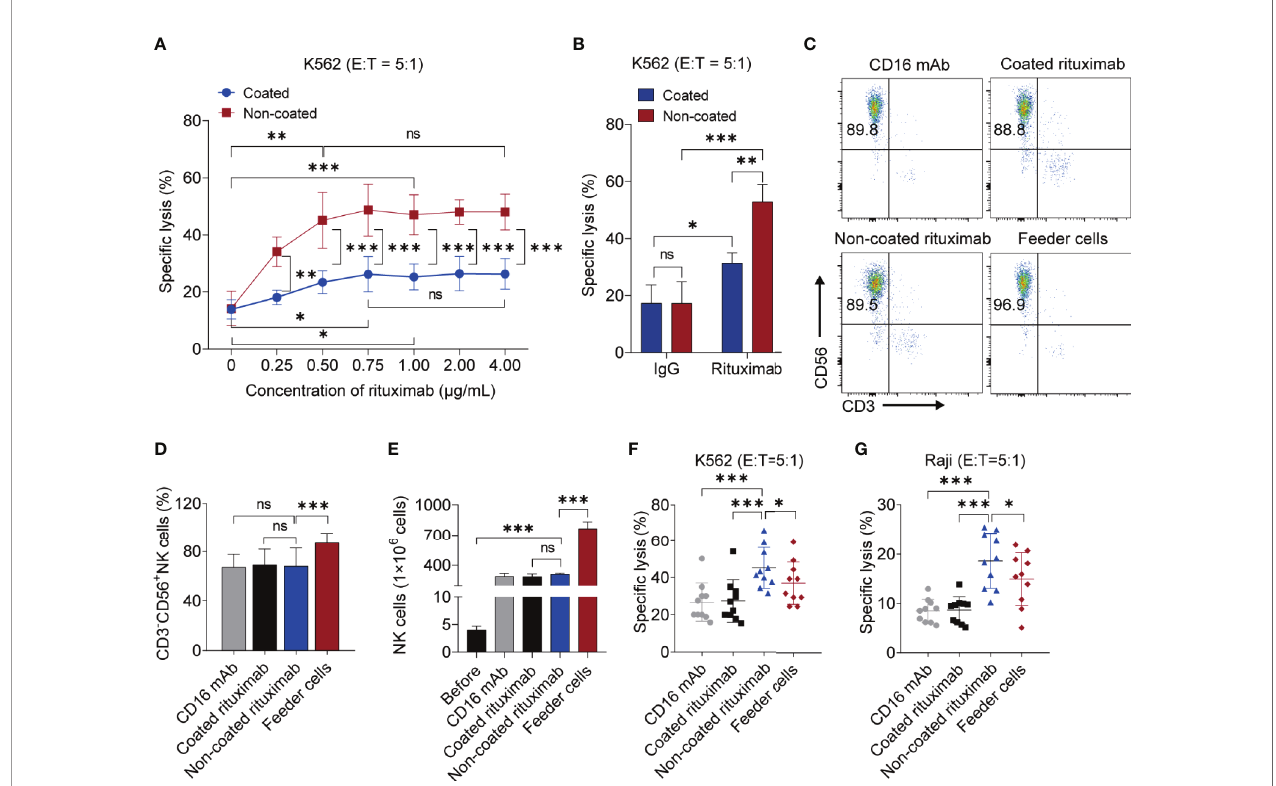
FIGURE 1 | NK cells induced by non-coated rituximab have stronger antitumor activity. (A) Titration of rituximab for NK cell expansion. NK cells were expanded with different concentration of coated and non-coated rituximab for 3 d and then cultured in media without rituximab for 11 d. The cytotoxicity of induced NK cells was determined by calcein-release assay. n = 5 donors, ns: not signi fi cant, p > 0.05, * p < 0.05, ** p < 0.01, *** p < 0.001; two-way ANOVA and two-tailed paired t-test. (B) Cytotoxicity of NK cells induced by rituximab and human IgG1 Isotype Control. n = 5 donors, ns, not signi fi cant, p > 0.05, * p < 0.05, ** p < 0.01, *** p < 0.001; two-way ANOVA. (C) Representative fl ow cytometry analysis of the percentage of CD3 − CD56 + NK cells induced by coated CD16 mAb, coated rituximab, non- coated rituximab, and K562-IL21 feeder cells. (D) Graph showing the percentages of NK cells induced by four different methods for 14 d. n = 10 donors, ns: not signi fi cant, p > 0.05, *** p < 0.001; one-way ANOVA. (E) Comparative analysis of NK cell number before and after induction by four different methods. n = 5 donors, ns: not signi fi cant, p > 0.05, *** p < 0.001; one-way ANOVA. (F, G) Comparative analysis of NK cell cytotoxicity before and after induction by four methods. NK cell cytotoxicity was determined by calcein-release assay. n = 10 donors, * p < 0.05, *** p < 0.001; one-way